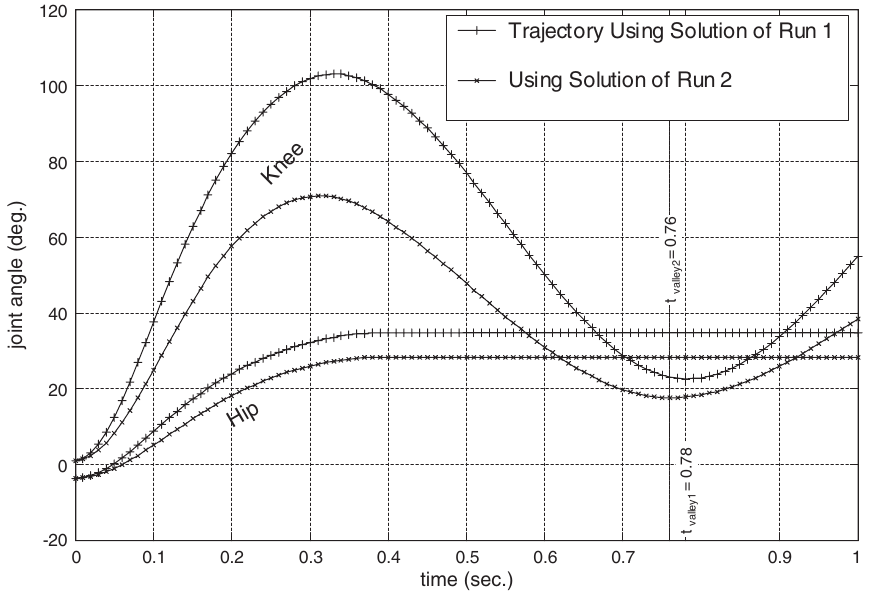
Fig. 8. Knee and hip joint trajectories with spring parameters optimized for maximum possible swing duration.